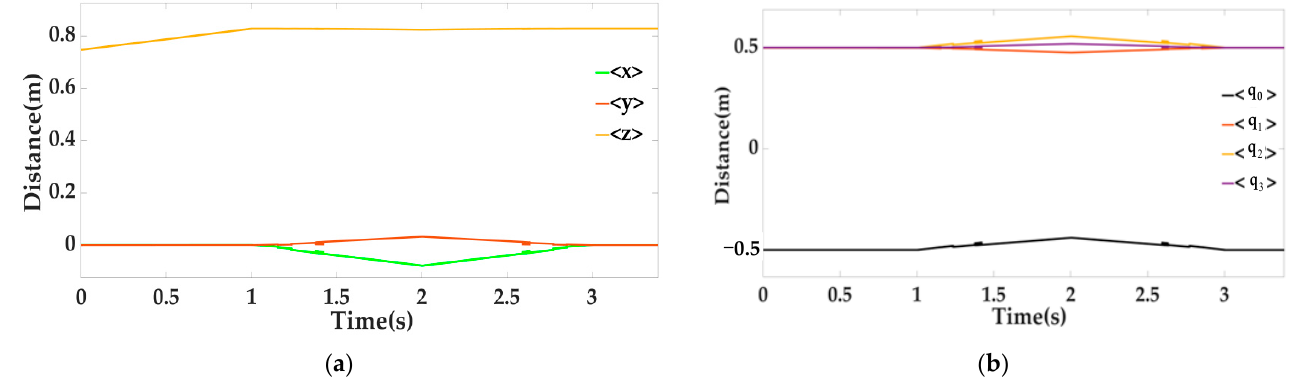
Figure 16. The pose curve of the moving platform relative to the static platform, where ( a ) is the quaternion curve diagram and ( b ) is the distance curve diagram.